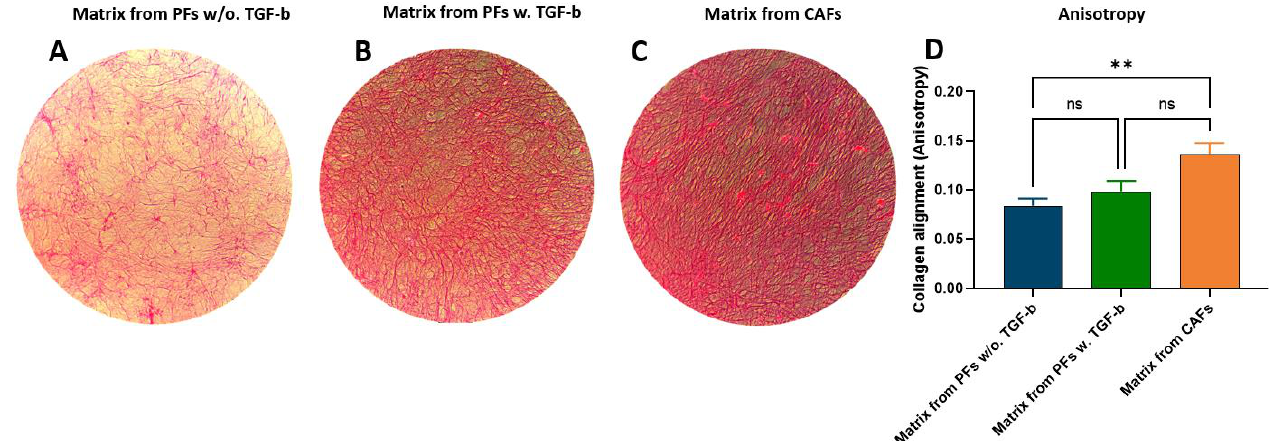
(Figure 4D, also represented by the length of the green line, Figure S1: Decellularized matrices). The mean orientation of the fibers in PFs matrix seemed more vertical compared to more horizontal fibers in CAF matrix (represented by the orientation of the green line, Figure S1: Decellularized matrices).